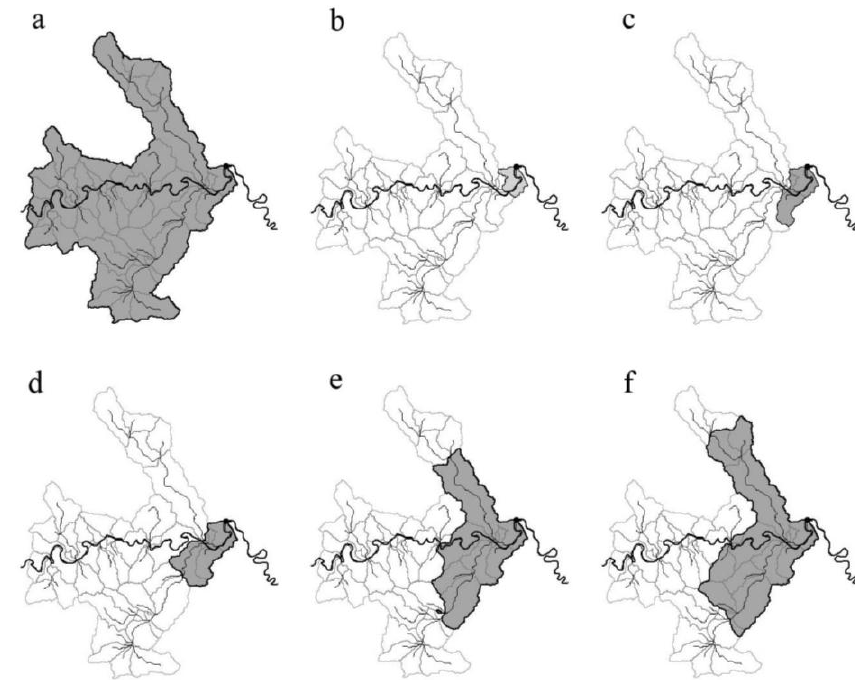
Figure 5. Illustration of how the multi-scale watersheds were defined: ( a ) The whole watershed for Site 1. ( b ) Definition of the Zone 1. ( c ) Definition of the Zone 2.